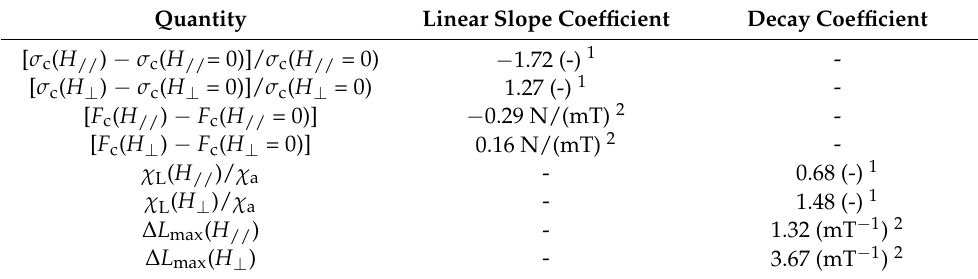
Figure 11. Peak parameters: critical stress σ c and maximal susceptibility change versus the applied magnetic field. Table 2. Fitting parameters for the critical stress and Force versus fields ( H // and H ⊥ ). Quantity Linear Slope Coefficient Decay